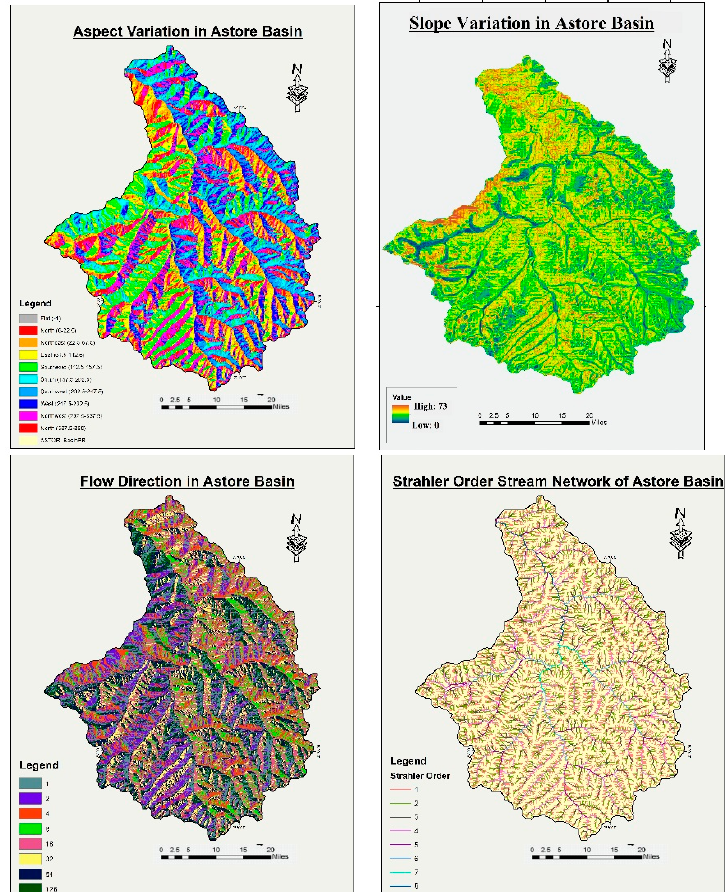
Figure 3. Hydrological and topographical variables derived from the Advanced Spaceborne Thermal Emission and Reflection Radiometer (ASTER) global digital elevation model.